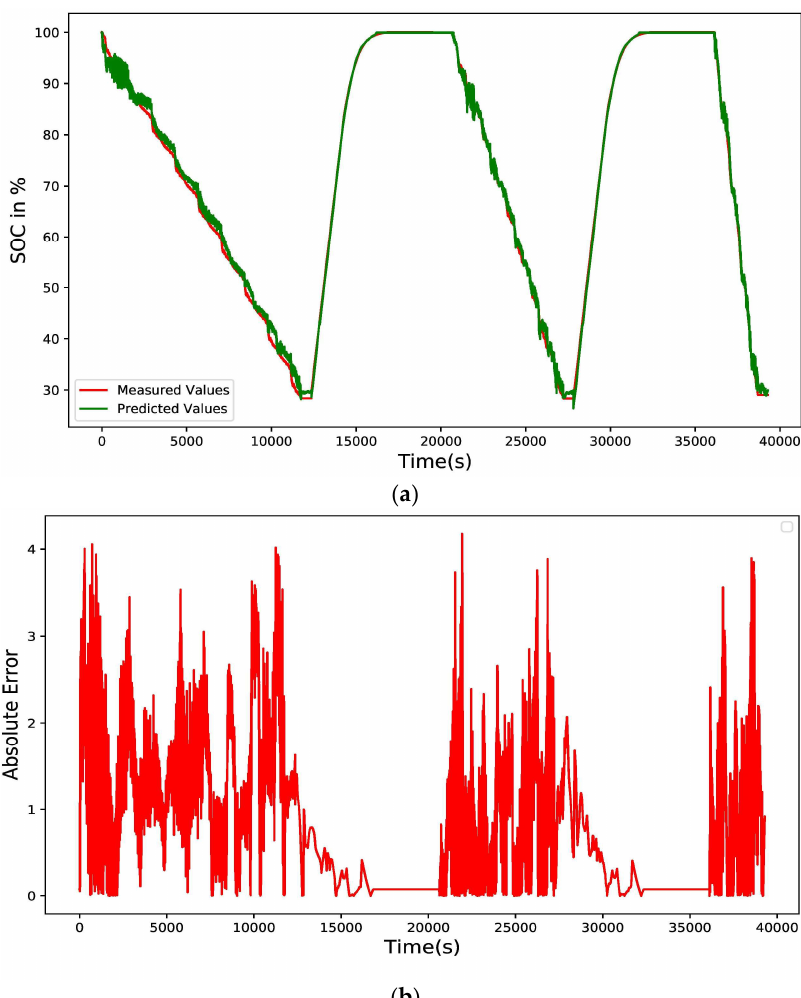
Figure 10. Performance of the LSTM model at −10 °C ( a ) measured and predicted SOC values and ( b ) absolute errors from the test data.